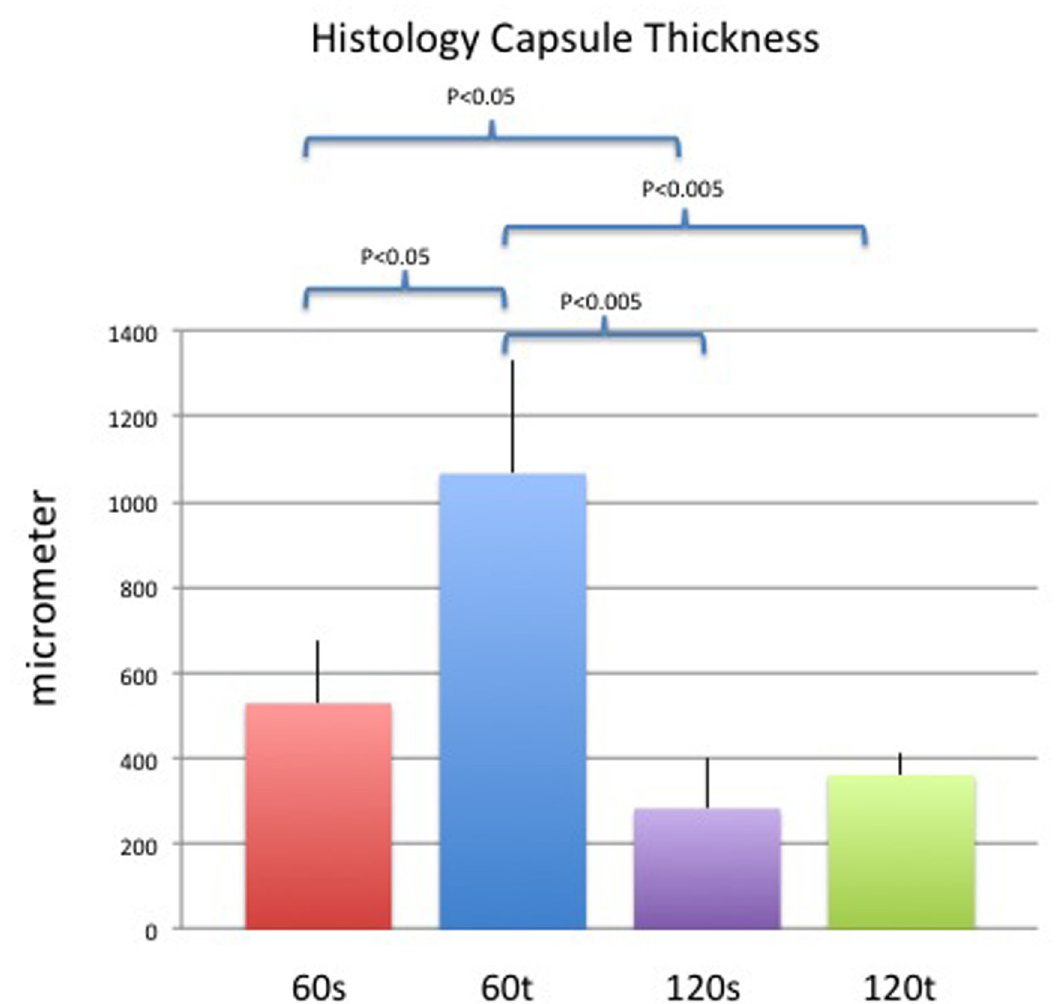
Fig 6. Mean (+/- standard deviation) capsule thickness measurements in histology sections of each study group. P < 0.05 and p < 0.005 were considered statistically significant and highly